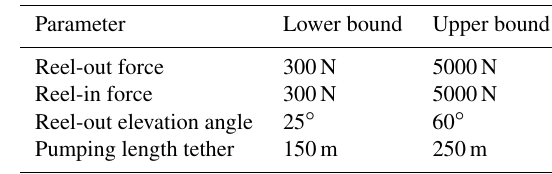
Table 5. Cycle setting parameters, which are varied for maximising the mean cycle power and their corresponding limits defining the search space. The limits are chosen by judgement of the authors for being representative for the analysed